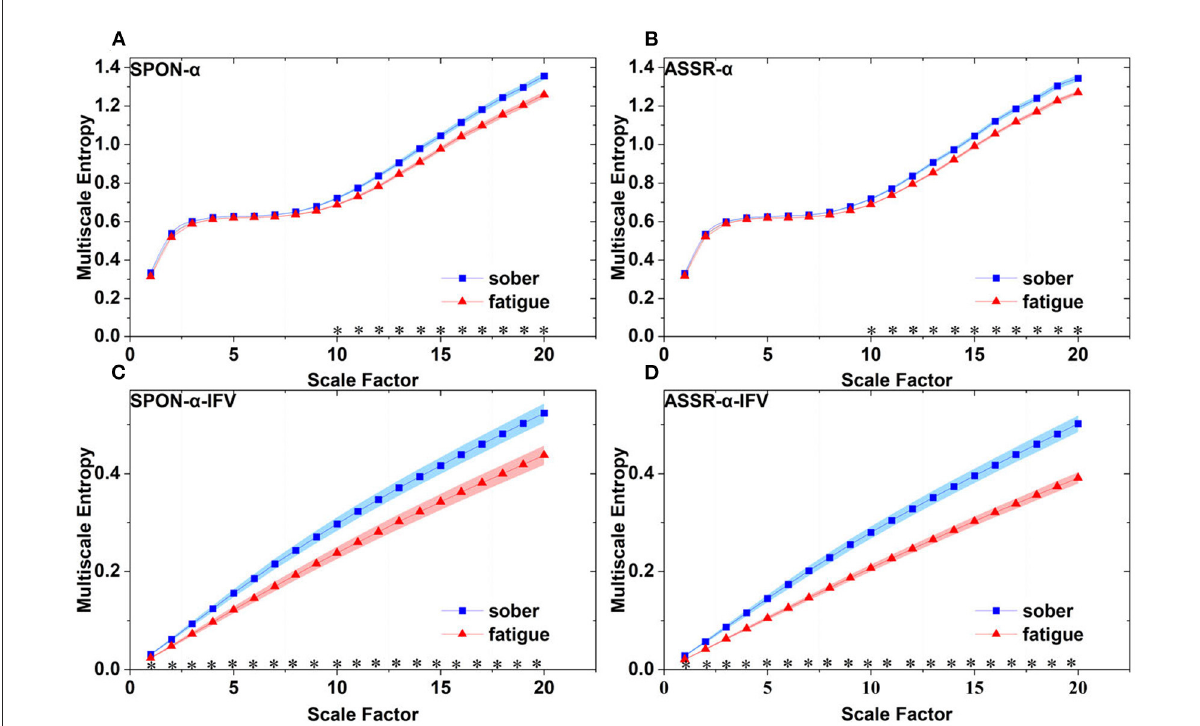
FIGURE8 Comparison of MSE from frontal lobe (channel T3) on: (A) alpha rhythm from spontaneous EEG (SPON- α ), (B) alpha rhythm from ASSR (ASSR- α ), (C) IFV in alpha rhythm from spontaneous EEG (SPON- α -IFV), and (D) IFV in alpha rhythm from ASSR (ASSR- α -IFV). The sign * indicates significance at p < 0.05. Shades indicate the standard errors.